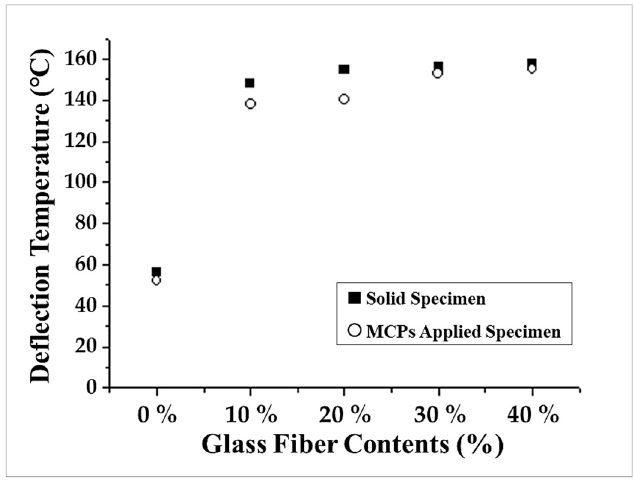
Figure 10. Deflection temperature of specimens.